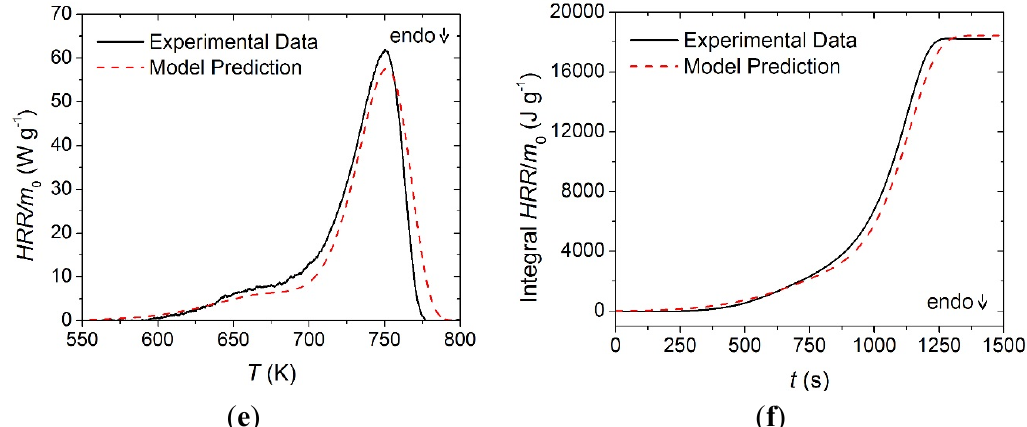
Figure 10. Normalized heat release rate and integral heat release rate data collected in MCC experiments and model predicted curves for: ( a ) and ( b ) the face yarn layer; ( c ) and ( d ) the middle layer; and ( e ) and ( f ) the base layer. Error bars were omitted due to small magnitude scatter.